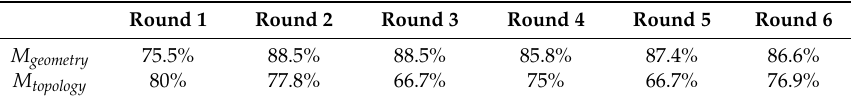
Table 1. Quality measures of the updating experiment.